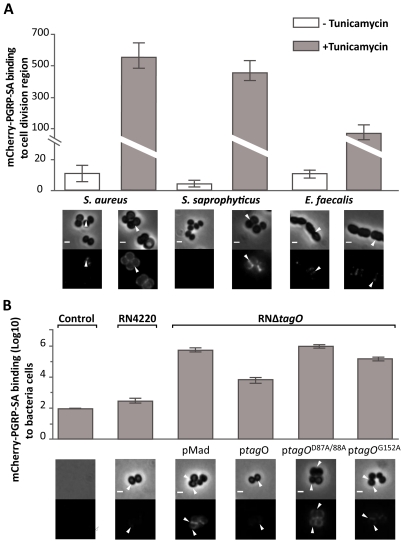
WTA reduce PGRP-SA binding at the bacterial cell surface.Grey panels are phase-contrast images of bacterial cells (white scale bar represents 1 µm), and black panels mCherry-PGRP-SA binding; white arrowheads highlight binding to the lateral cell surface or region of cell division. The binding of mCherry-PGRP-SA to individual bacterial cells (n = 50) was quantified, and represented as the median (with 25% and 75% inter-quartile range). (A) mCherry-PGRP-SA binding to Gram-positive bacteria grown with or without tunicamycin, an inhibitor of WTA synthesis. mCherry-PGRP-SA binding to the cell division region, rather than total binding, was measured because binding at the former was consistently enhanced for all treated bacteria species. Mann-Whitney U tests were used to compare differences for treated and untreated between each type of bacteria (P<0.05 in all cases). (B) RNΔtagO mutant background rescued with variants of the tagO gene – expressed from a replicative pMAD vector – produce varying levels of WTA, given as a% relative to the wild type RN4220: pMAD vector (0%), ptagO (90%), ptagOD87A/D88A (0%), ptagOG152A (22%). Total binding of mCherry-PGRP-SA to the surface of live bacteria increases as the levels of WTA are reduced. Kruskal-Wallis analysis followed by Dunn's multiple comparison post-test, revealed significant differences for all comparisons (P<0.05) except for that between PGRP-SA binding to pMAD and ptagOD87A/D88A.